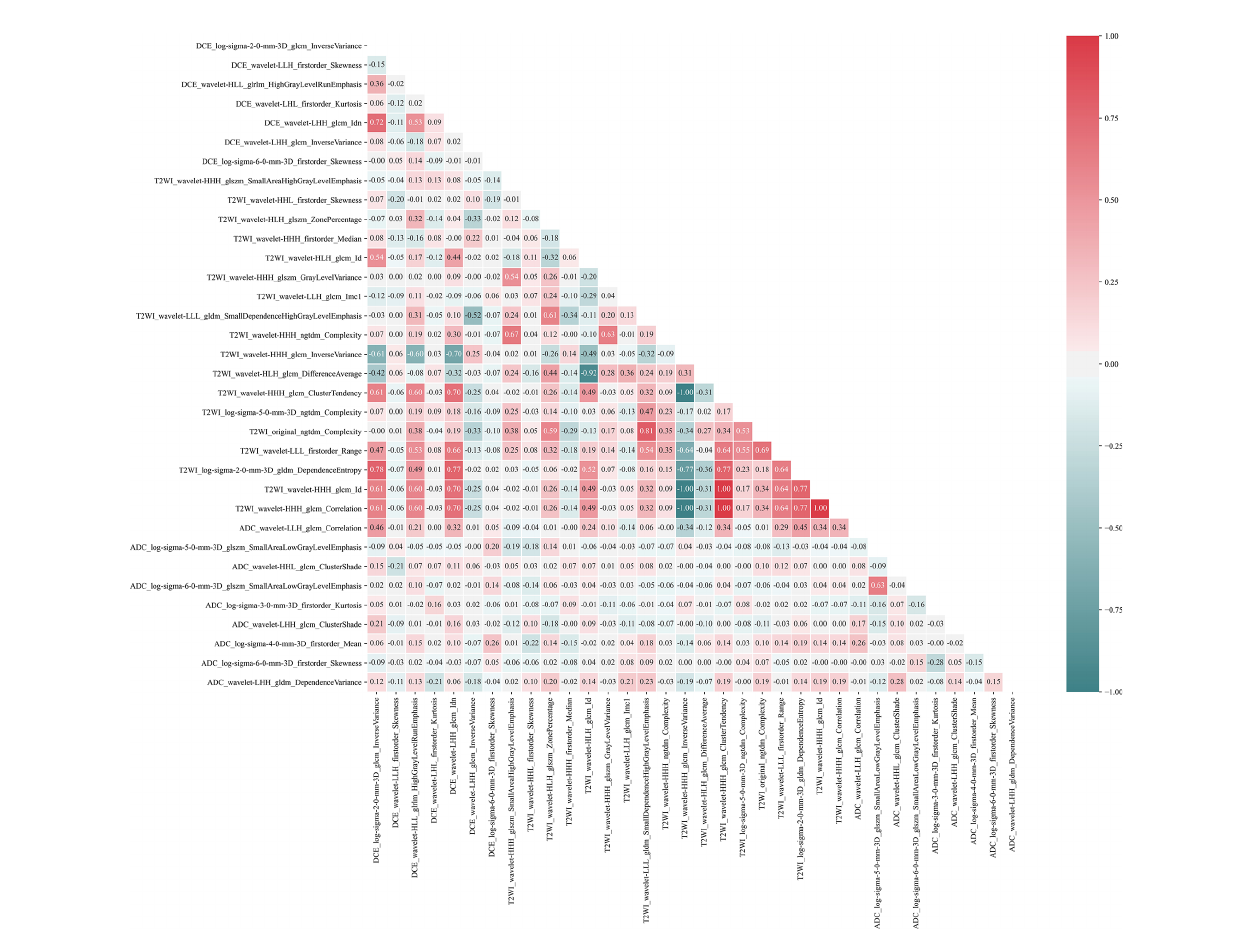
FIGURE 3 | Pearson correlation coef fi cient heatmap of selected features on predicting molecular subtype. Red color denotes a positive correlation, and green color denotes a negative correlation, and the shade of the color indicates the correlation